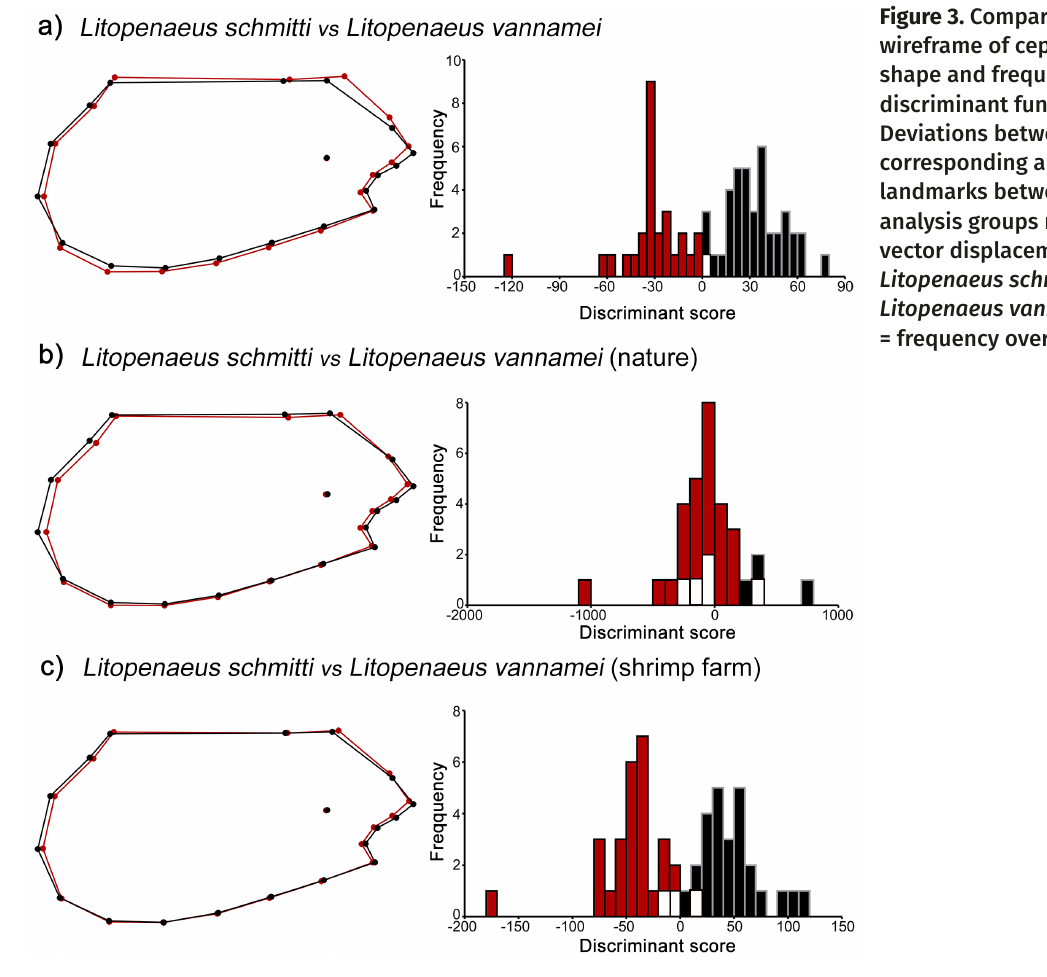
Figure 3. Comparison wireframe of cephalothorax shape and frequencies of discriminant function scores. Deviations between the corresponding anatomical landmarks between the analysis groups represent the vector displacement. Red = Litopenaeus schmitti ; Black = Litopenaeus vannamei ; White = frequency